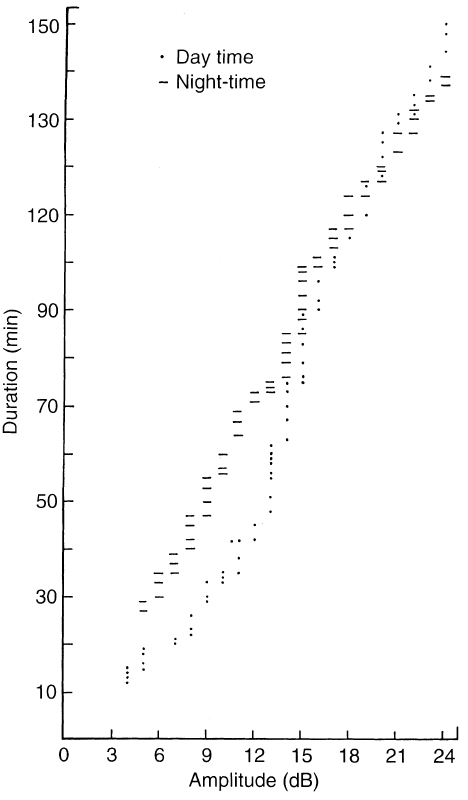
Fig. 5. Scatter plot of the fade period against amplitude; dot represents daytime and dash